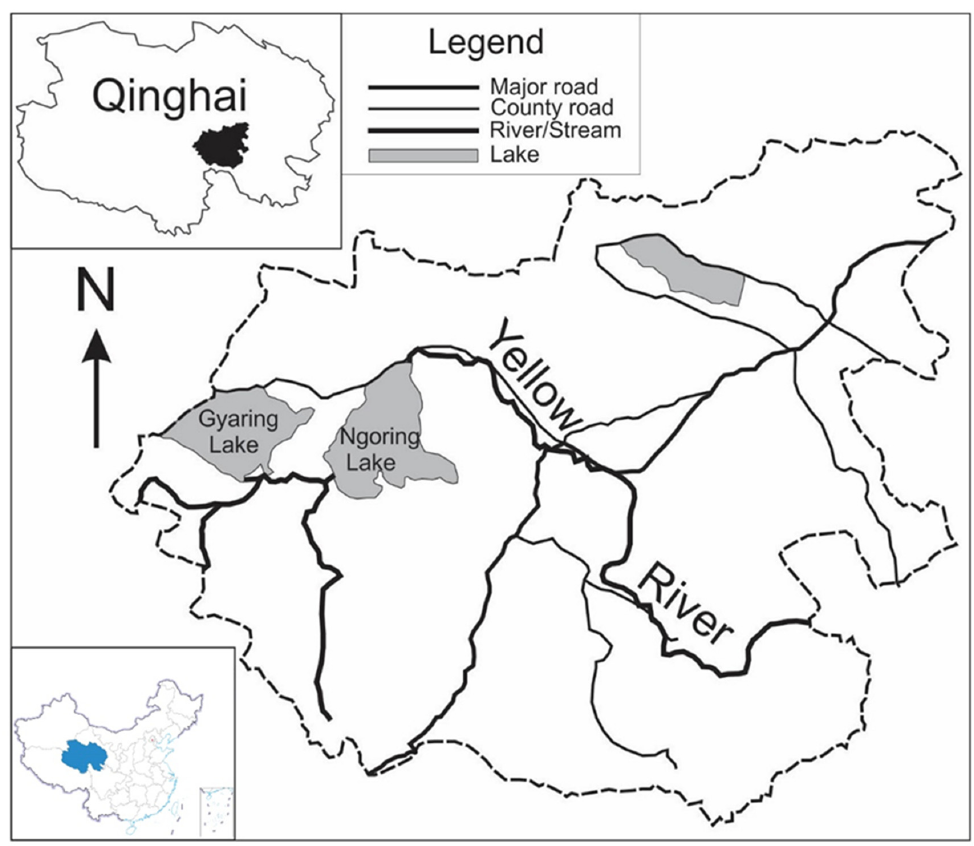
Figure 1. Location of the study area in Qinghai Province, West China.